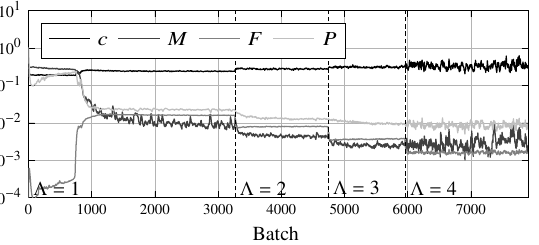
Figure 13. Progression of the evaluator values during training. The results were validated using n = 100 randomly generated input data points, called validation data. These data points were not part of the training. The corresponding optimized geometries were conventionally calculated by the top88 algorithm. The results of the comparison (PEN and top88) of the 100 validation data points are summarized in the plots in Figure 14.